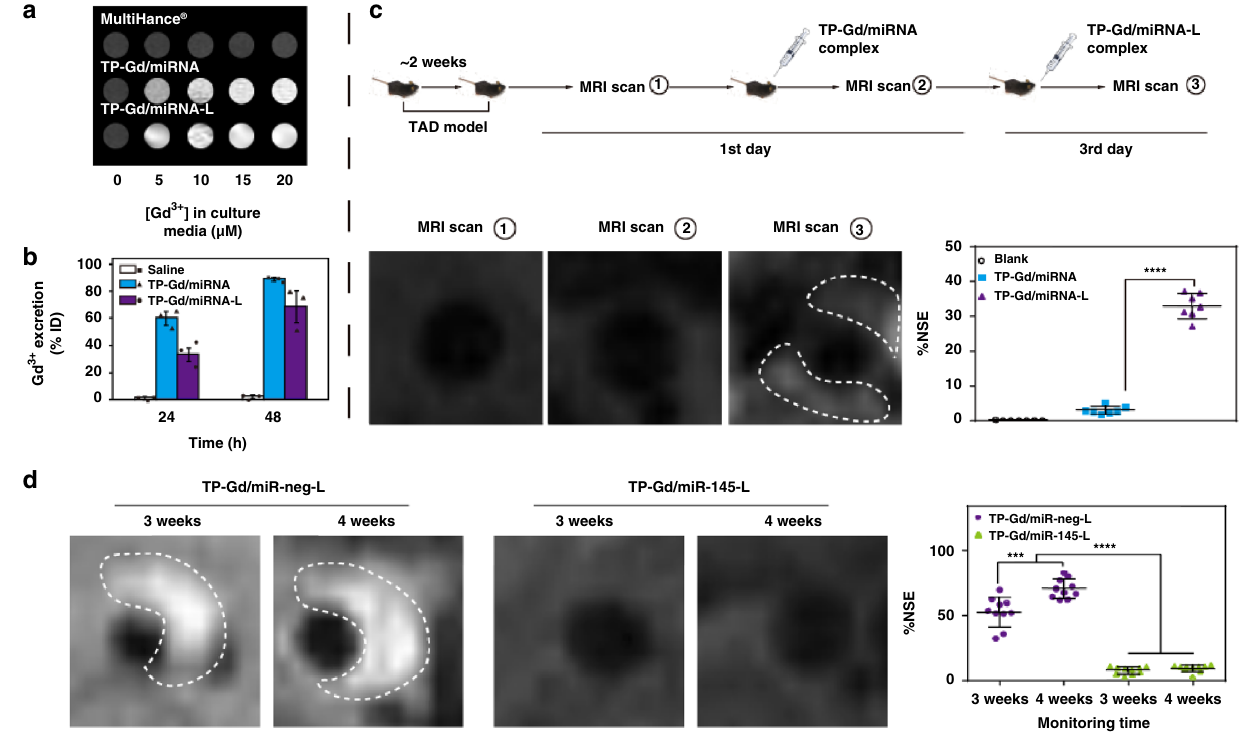
Fig. 7 a T 1 -weighted MR images in SMCs under different concentrations of Gd 3 + . b ICP-MS analysis of Gd 3 + amounts in the urine of mice collected at different periods after the infection of saline, TP-Gd/miR-neg or TP-Gd/miR-neg-ColIV. c MRI diagnosis and noninvasive monitoring on BAPN-induced TAD model: speci fi c experimental procedures of diagnosis, representative MR images (white dashed area represented MRI enhancement) and normalized percentage signal enhancement (%NSE) of thoracic aortic arches from two-week TAD models after the injection of different complexes. d Representative MR images (white dashed area represented dissections) of TAD and %NSE of thoracic aortic arches at different periods during the treatments of TP-Gd/ miR-neg-ColIV and TP-Gd/miR-145-ColIV, where TP-Gd/miR-neg-ColIV was used as the detection agent. (*** p < 0.001 and **** p < 0.0001, see “ Statistical analysis ” in “ Methods ” ; n = 3 animals, error bars represent standard deviation in Fig. 7b; n ≥ 7 animals, error bars represent standard deviation in c , d ; source data of b – d are provided as a Source Data fi